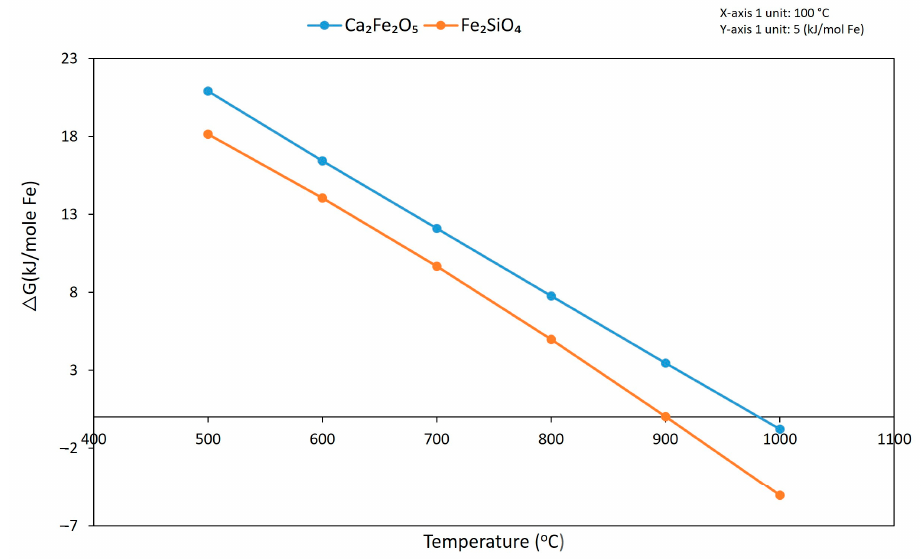
Figure 16. Gibbs free energy and enthalpy changes of Reactions (7) and (8) calculated by Factsage 8.